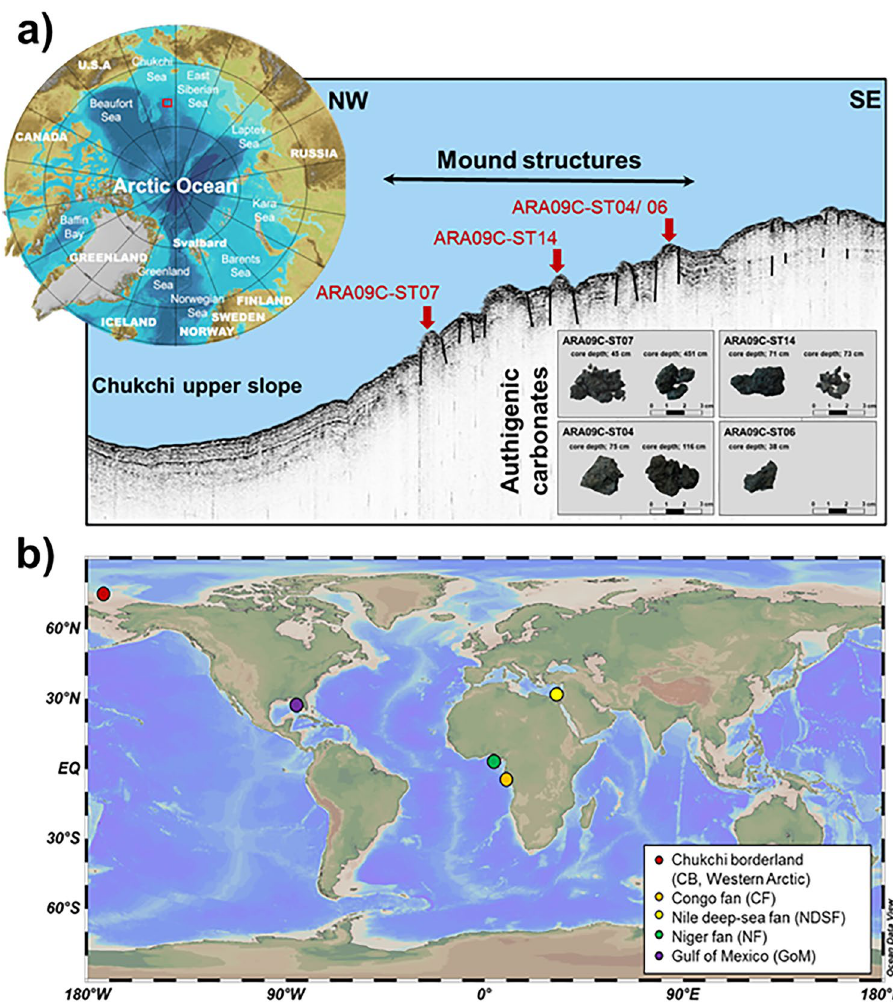
Figure 1. Map showing ( a ) the mound structures discovered in the Chukchi Borderlands (CB) with authigenic carbonates investigated in this study and ( b ) four comparison study sites: Congo fan (CF), Nile deep-sea fan (NDSF), Niger fan (NF), and Gulf of Mexico (GoM). The bathymetric map was generated with the International Bathymetric Chart of the Arctic Ocean Version 3.0 (https:// www. ngdc. noaa. gov/ mgg/ bathy metry/ arctic). The sub-bottom profile (SBP) image was acquired using a SBP120 equipment (frequency; 12 kHz, wide-beam angle; 90–120°, Kongsberg). The global ocean map was generated with the Ocean Data View version 5.1.4 (GlobalHR, https:// odv. awi.